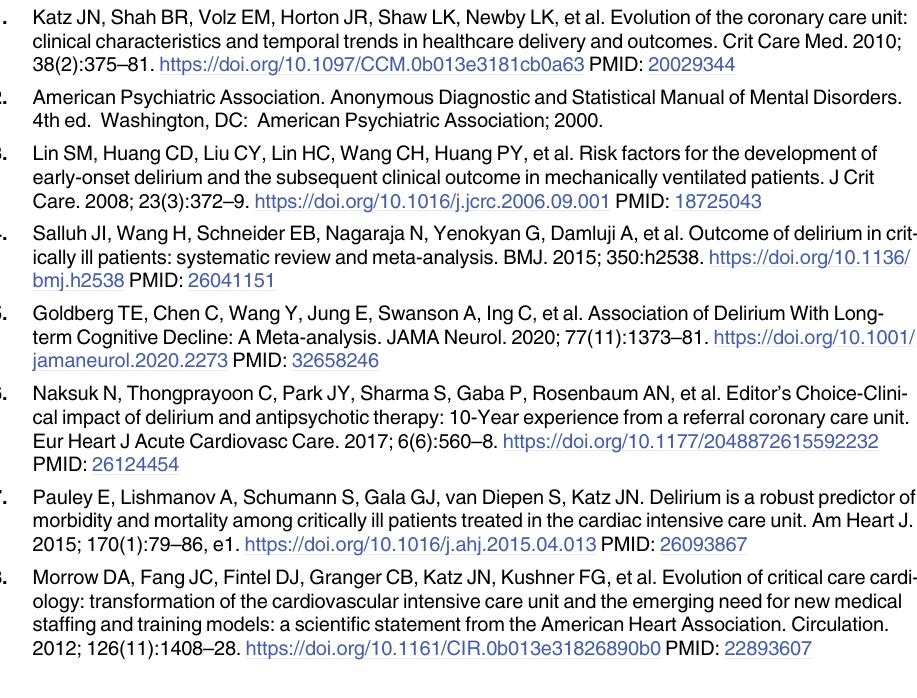
S1 Table. Definition of delirium